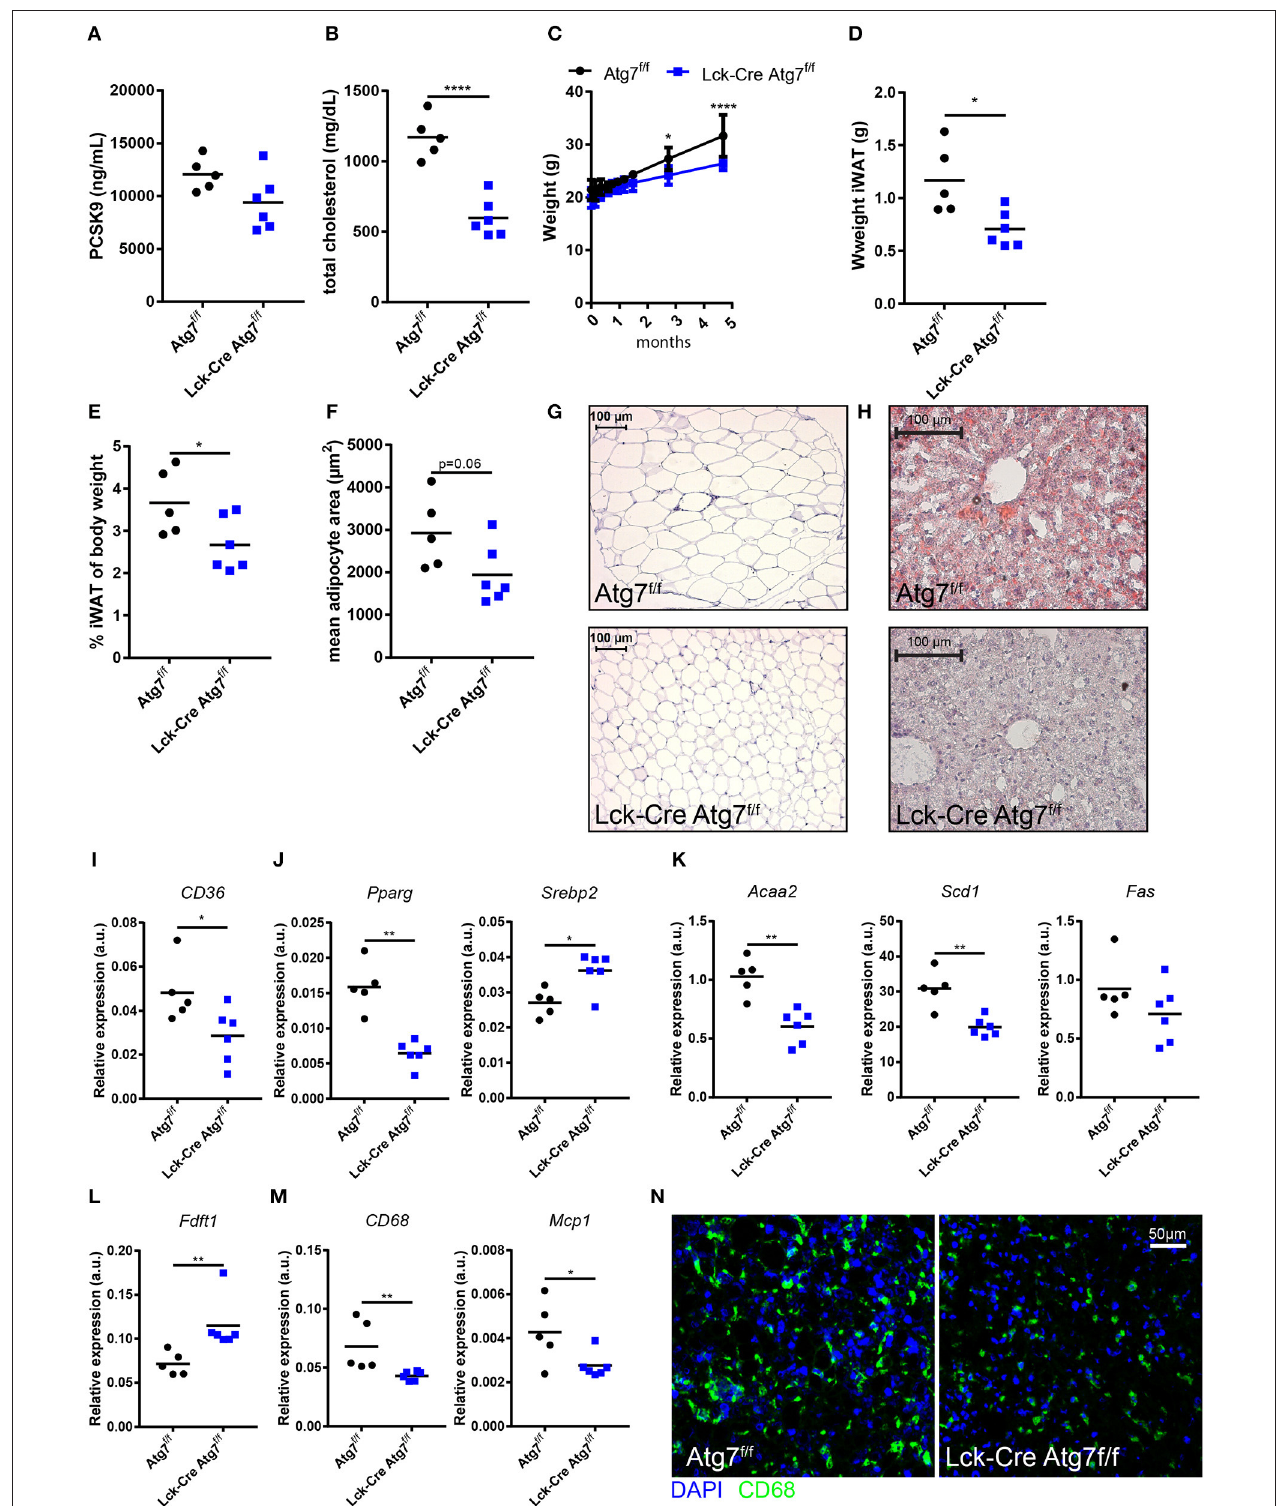
FIGURE 2 | Atg7 deficiency in T cells decreased hepatic steatosis and dyslipidemia. (A) PCSK9 levels in serum. (B) Total cholesterol levels in serum. (C) Weight of the mice over the course of the experiment. (D) Weight inguinal white adipose tissue. (iWAT). (E) Weight iWAT as a percentage of body weight at